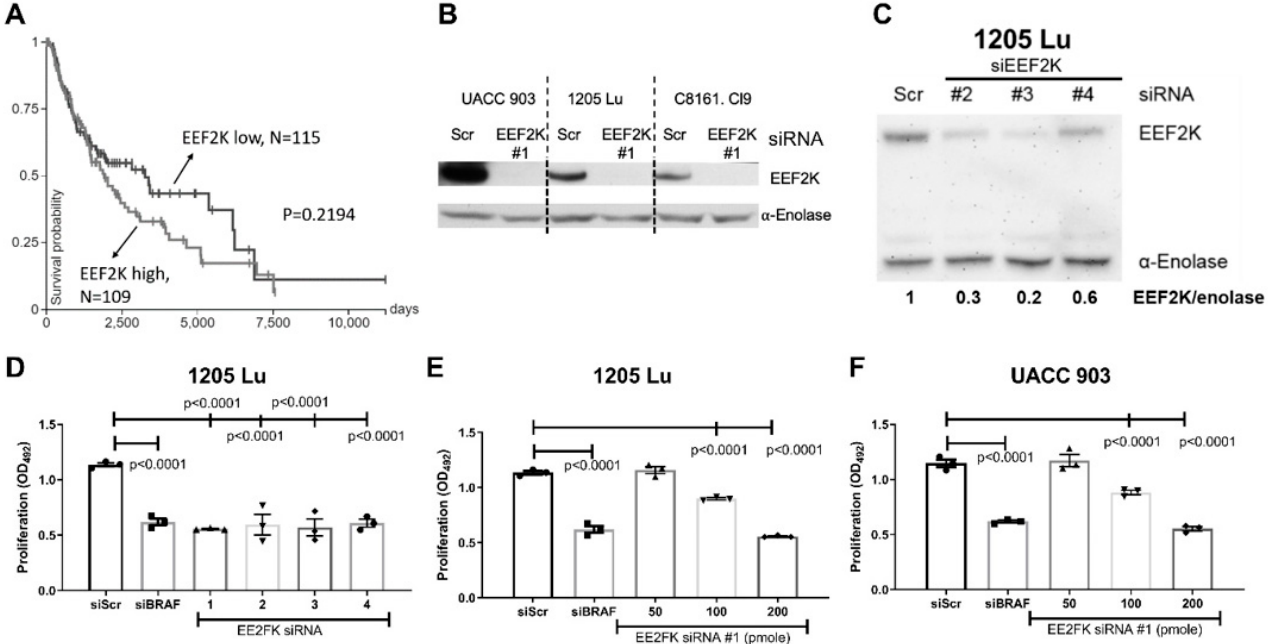
Figure 1. Knockdown of EEF2K inhibited melanoma cell proliferation. Data from the TCGA database suggest poorer survival with EEF2K overexpression ( A ) in melanoma patients. n = 115 for melanoma patients with low EEF2K; n = 105 for melanoma patients with high EEF2K. p = 0.2194. The data are available through the UCSC Xena Cancer Browser. Western blot showing knockdown of EEF2K with siRNA #1 in UACC 903, 1205 Lu and C8161Cl9 cell lines ( B ). Alpha-enolase served as the control for protein loading. Western blot showing knockdown of EEF2K with siRNAs #2, 3, 4 in UACC 903 ( C ). siRNA knockdown of EEF2K (siEEF2K) significantly reduced the growth of 1205 Lu ( D ) cells after 72 h in an MTS metabolism assay. Additionally, siRNA #1 dose dependently reduced the growth of 1205 Lu ( E ) and UACC 903 cells ( F ). siRNA to BRAF served as a positive control while scrambled (scr) siRNA served as the negative control. Significance was compared to scrambled knockdown by one-way ANOVA followed by Dunnett’s as post-hoc analysis. Experiments were replicated for n = 3 and representative graphs are shown.